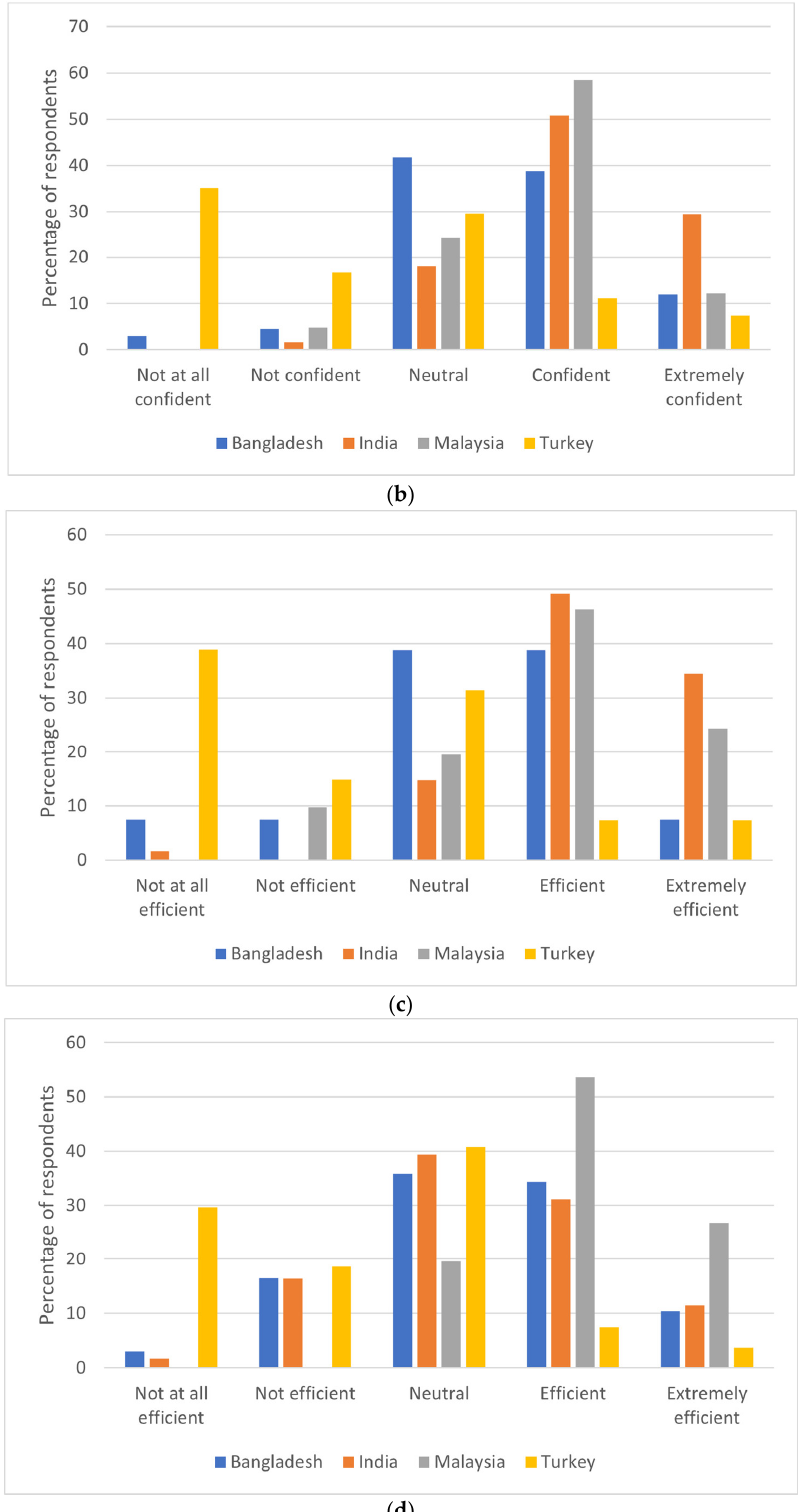
Figure 1. ( a ) Respondents’ confidence in diagnosing dengue by country of practice. ( b ) Respondents’ confidence in treating dengue by country of practice. ( c ) Respondents’ clinical practice setting efficiency by country of practice. ( d ) Government efficiency in handling dengue cases by country of